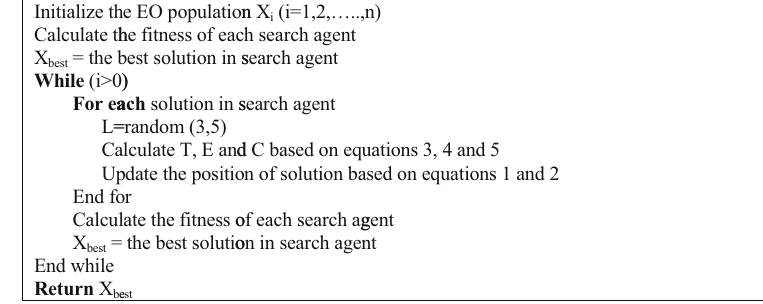
Table 3 ( average and standard deviation ) con fi rms that EOO achieved the optimal value in nine bench -